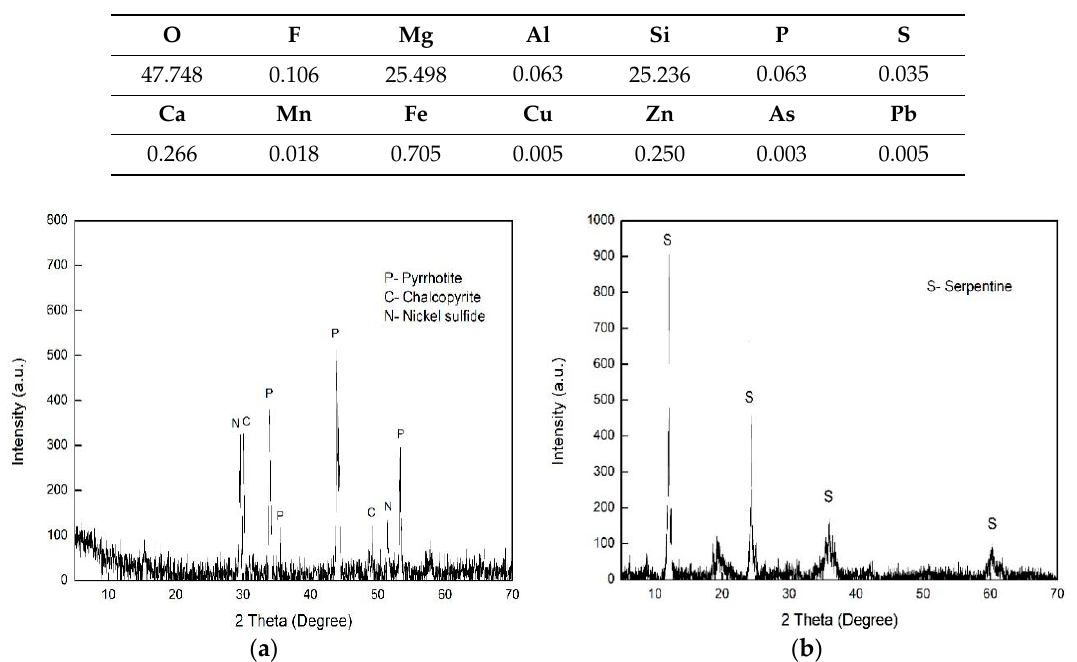
Figure 1. XRD spectrums of: ( a ) sulfide ore and ( b ) serpentine mineral.